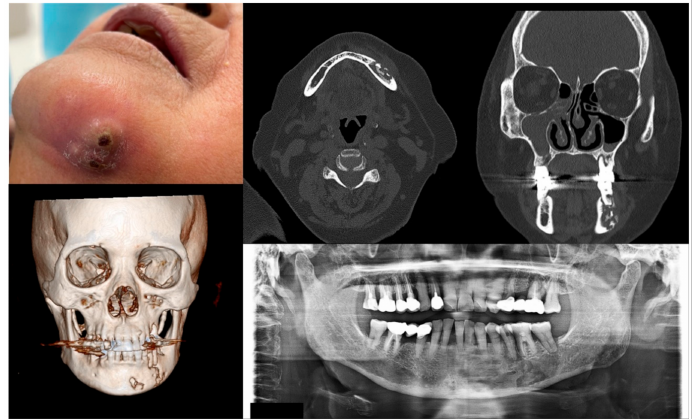
Figure 4. Case 4 with MRONJ Stage 3: Clinical photo, panoramic view, and computed tomography imaging including three-dimensional reconstruction showing extraoral fistula and necrotic bone on the mandibular left anteroposterior area. An 80-year-old female patient with a history of intravenous administration of ibandronate and denosumab for one year was presented with inflammation and skin fistula on the chin area. She had undergone periodontal treatment on the left lower posterior teeth three months ago due to a periodontal abscess, but she was referred for recurrence with facial swelling from a private dental clinic. Bony lesions involving the inferior border of the mandible and the presence of extraoral fistula were